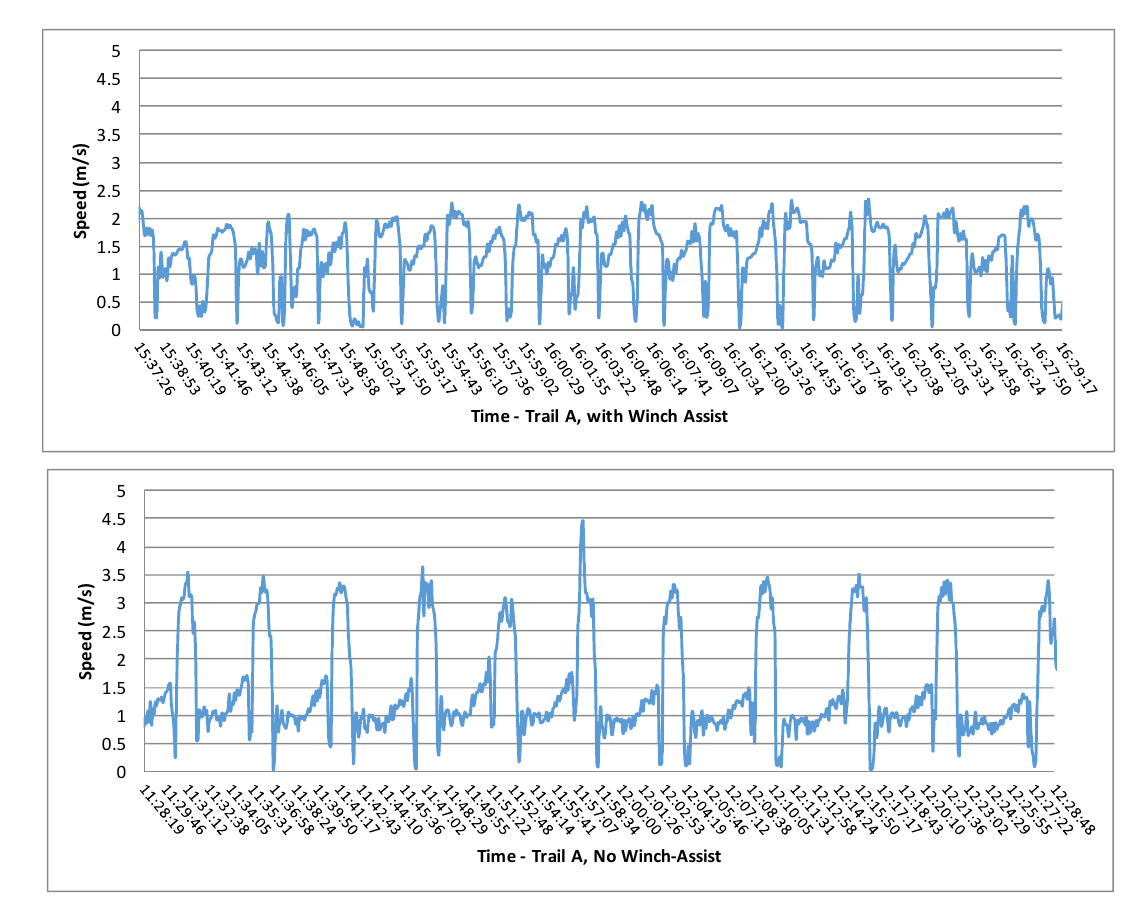
Figure 4. Skidder speed graphs (speed on the Y axis and time on the X axis). The graphs were recorded on Trail A, and show the results for the skidder with ( a ) and without ( b ) winch-assistance. They show the high peak and fast speed ramp on the empty travel down the hill and the much smaller peak and slower speed ramp as the loaded skidder struggles uphill.